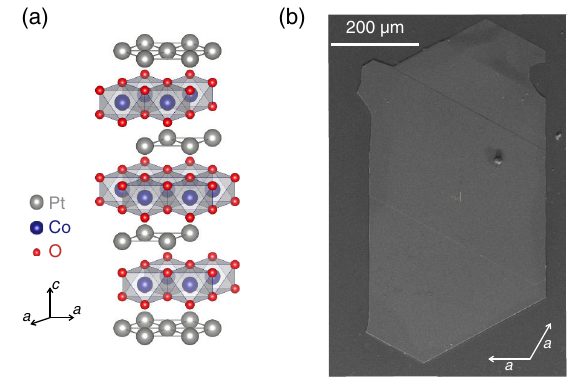
FIG. 1. (a) Delafossite crystal structure, shown on the example of PtCoO 2 . (b) Scanning electron microscopy (SEM) image of a crystal of PtCoO 2